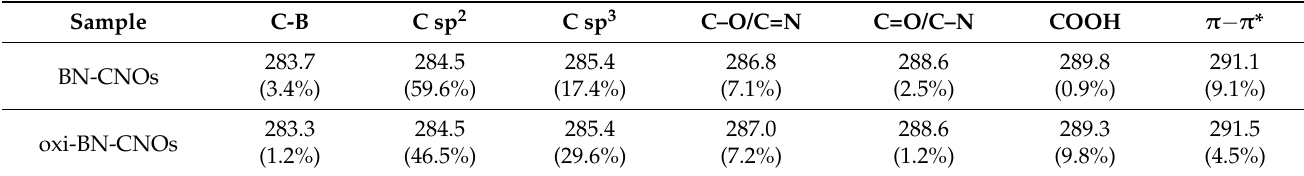
Table 2. Chemical state, positions (eV), and relative area percentages of the deconvoluted C 1s peaks obtained from XPS analyses of BN- and oxi-BN-CNOs.